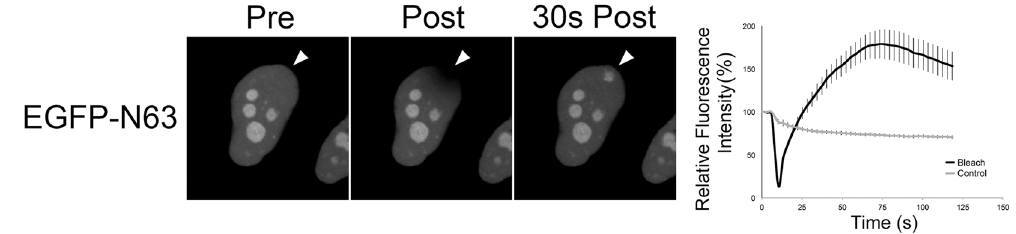
Figure 4. The N-terminal 63 amino acids of UL31 are sufficient to recruit EGFP to sites of laser microirradiation. Images of a live HeLa cell transfected with EGFP-N63 immediately before (Pre), immediately after (Post), and 30 seconds were acquired after the area indicated by the arrowhead was irradiated using an Olympus FV1000 laser-scanning confocal microscope. Images shown are representative of n = 12 cells analyzed in two independent experiments. Error bars are standard error of the mean (n = 12).